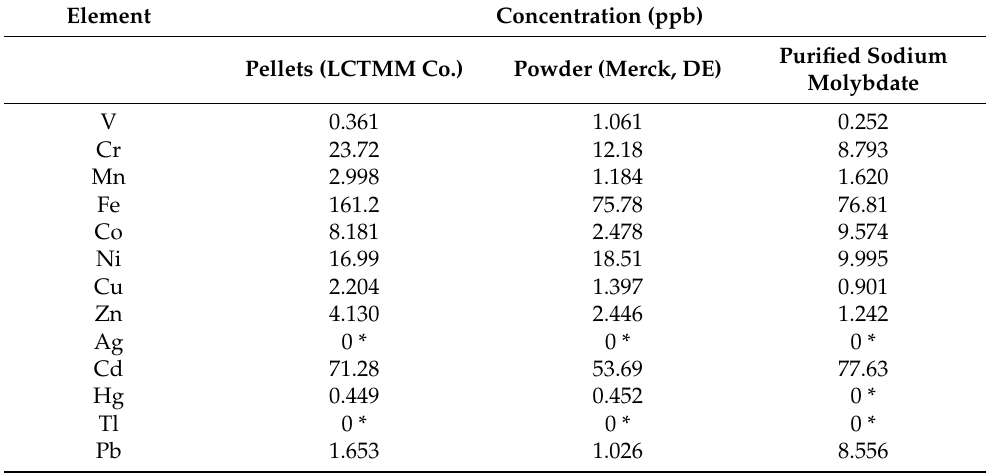
Table 4. Impurities concentration in the initial molybdenum pieces and in the final product (* below